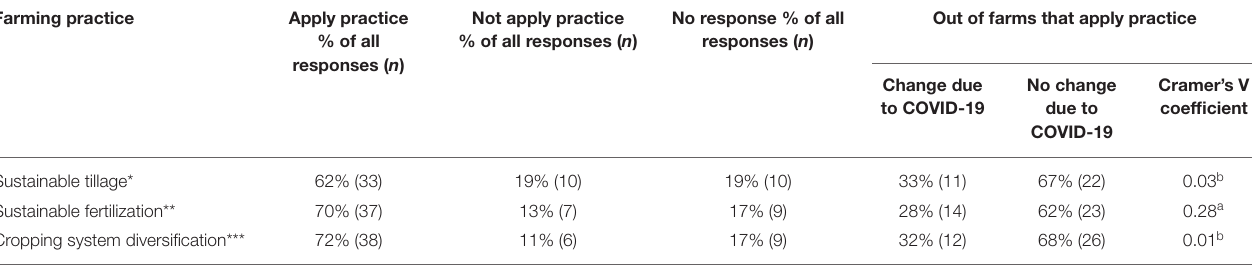
TABLE 5 | Farm management changes due to COVID-19, based on farming practices applied by surveyed producers. Farming practice